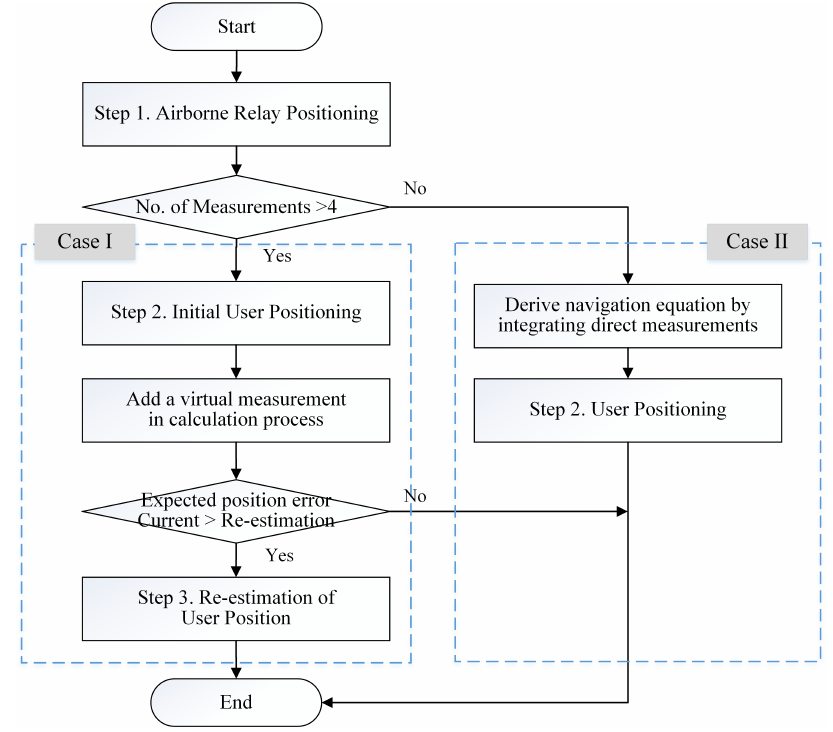
Figure 2. Positioning procedures of the enhanced